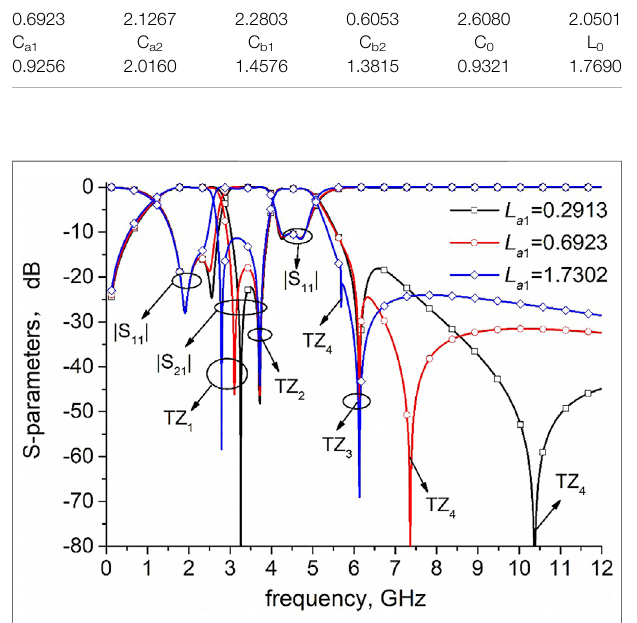
FIGURE 2 | Tunable TZ 1 and TZ 4 versus different L a 1 .